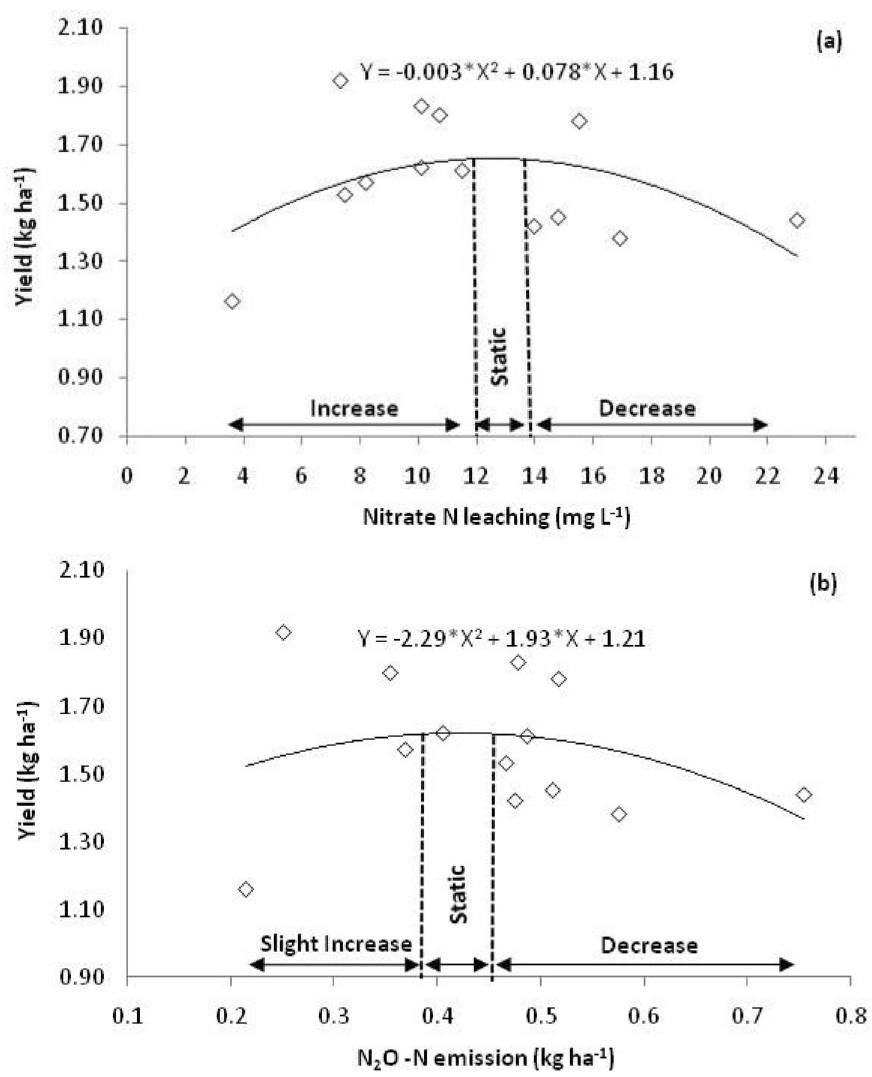
Figure 4. Effect of Nitrogen losses, ( a ) Nitrate leaching ( b ) N 2 O–N emission, on saffron yield in saffron growing cold humid region of North West